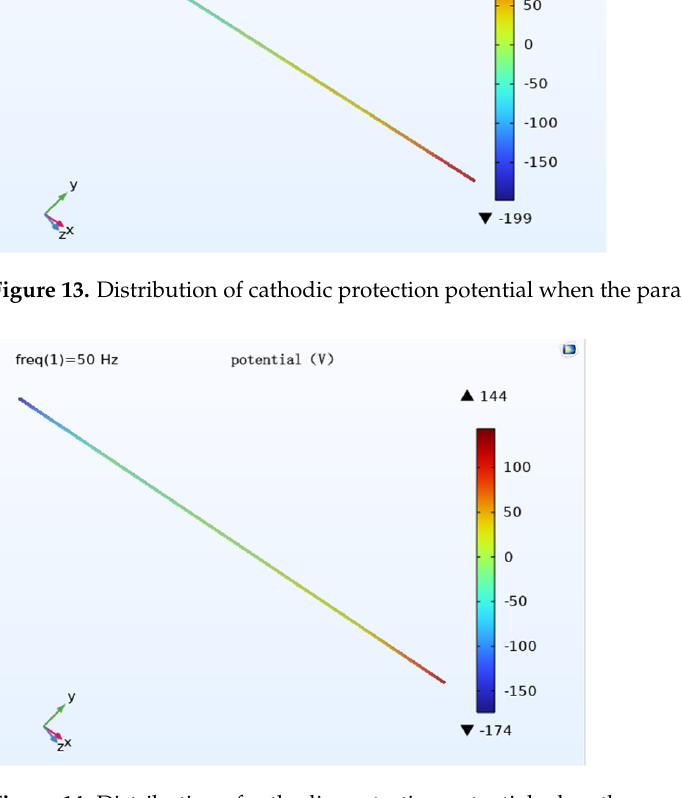
Figure 14. Distribution of cathodic protection potential when the parallel spacing is 10 m.